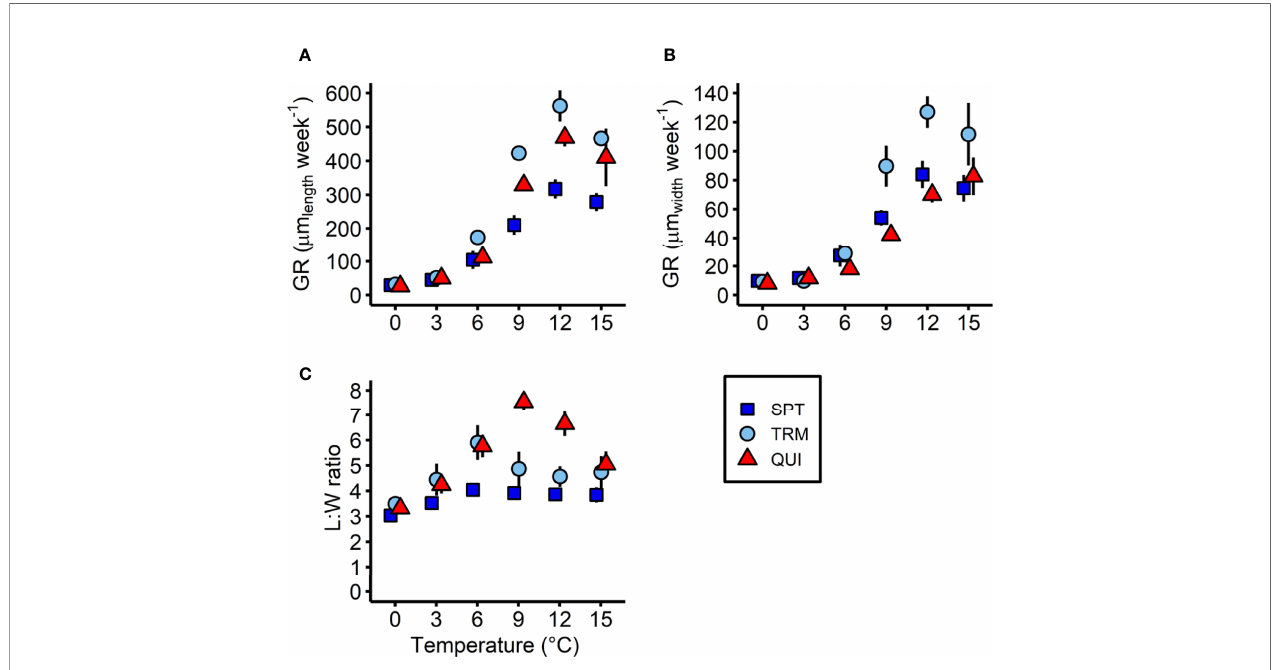
FIGURE 6 | Sporophyte growth parameters of Laminaria digitata in three populations (Spitsbergen, SPT; Tromsø, TRM; Quiberon, QUI) on day 21 between 0°C and 15°C in experiment 2. (A) Linear sporophyte growth rate (GR) in length, (B) in width and (C) sporophyte length:width (L:W) ratio. Values are expressed as the mean of means ± SD (n =